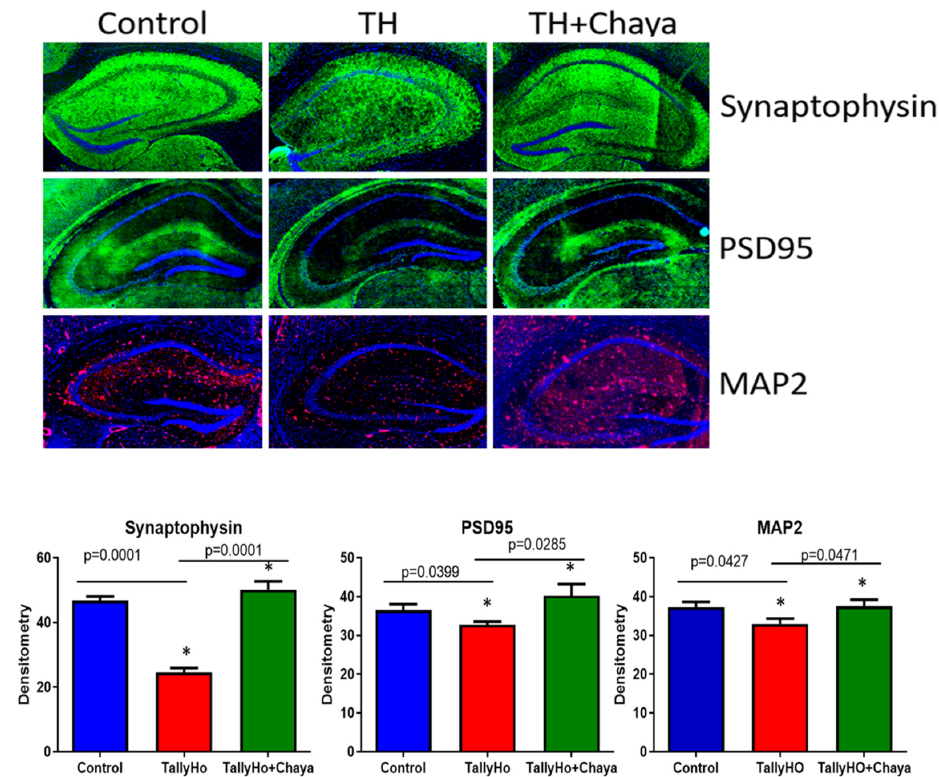
Figure 10. Immunofluorescence analysis of the hippocampal mitochondrial synaptic proteins and neuronal markers of 14-month-old non-diabetic control mice, TH mice fed with chaya, and TH mice fed with regular chow. The TH + chaya mice showed significantly increased levels of synaptophysin, PSD95, and Map2, which were reduced in the TH mice (synaptophysin, p = 0.0001; PSD95, p = 0.0285; and MAP2, p = 0.0471). * p = 0.01.